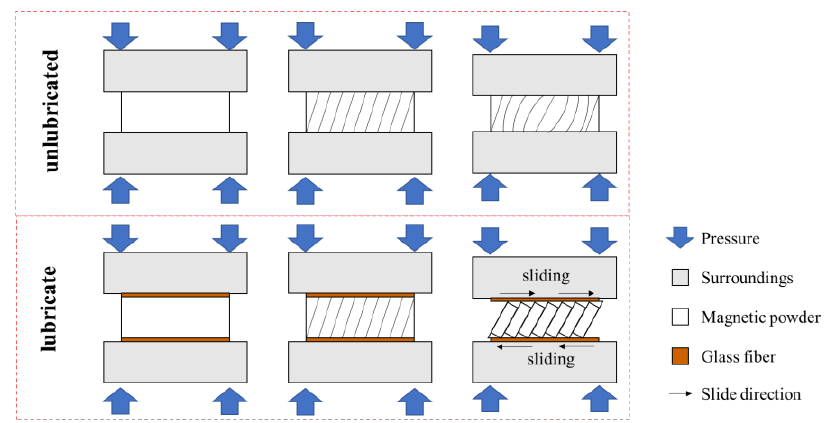
Figure 9. Diagram of the deformation with and without lubrication.